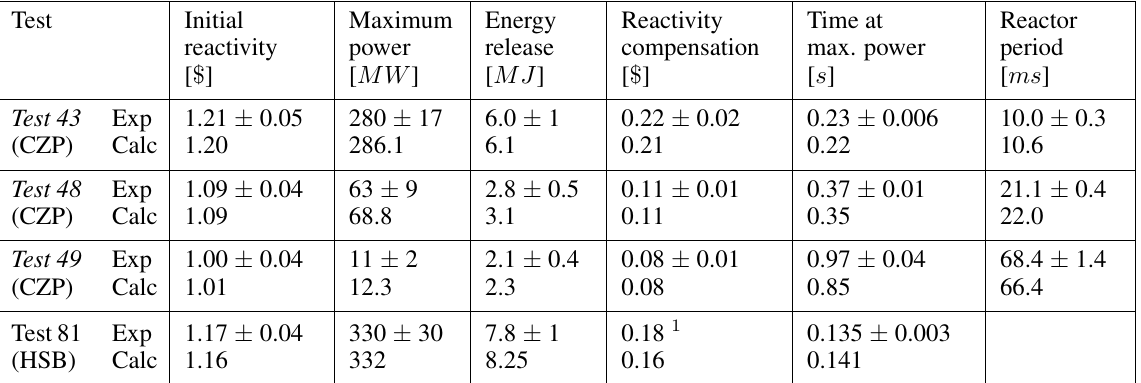
Table 2: Reactivity accident test results for Cold-Startup (CZP) and Hot-Standby (HSB) calculated with DYN3D-ATHLET in comparison with experimental data.